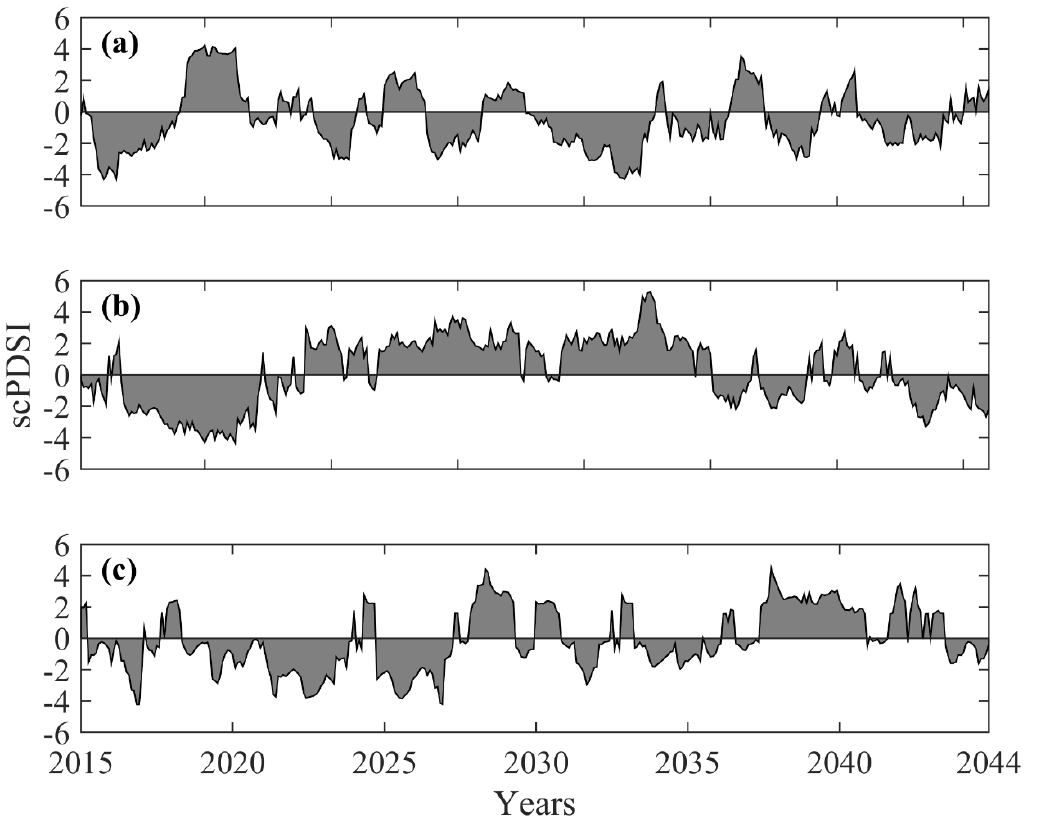
Figure 11. Grid averaged scPDSI values from 2015 to 2044 for study area KSB. ( a ) scPDSI values for SSP1-2.6; ( b ) scPDSI values for SSP2-4.5; ( c ) scPDSI values for SSP5-8.5.